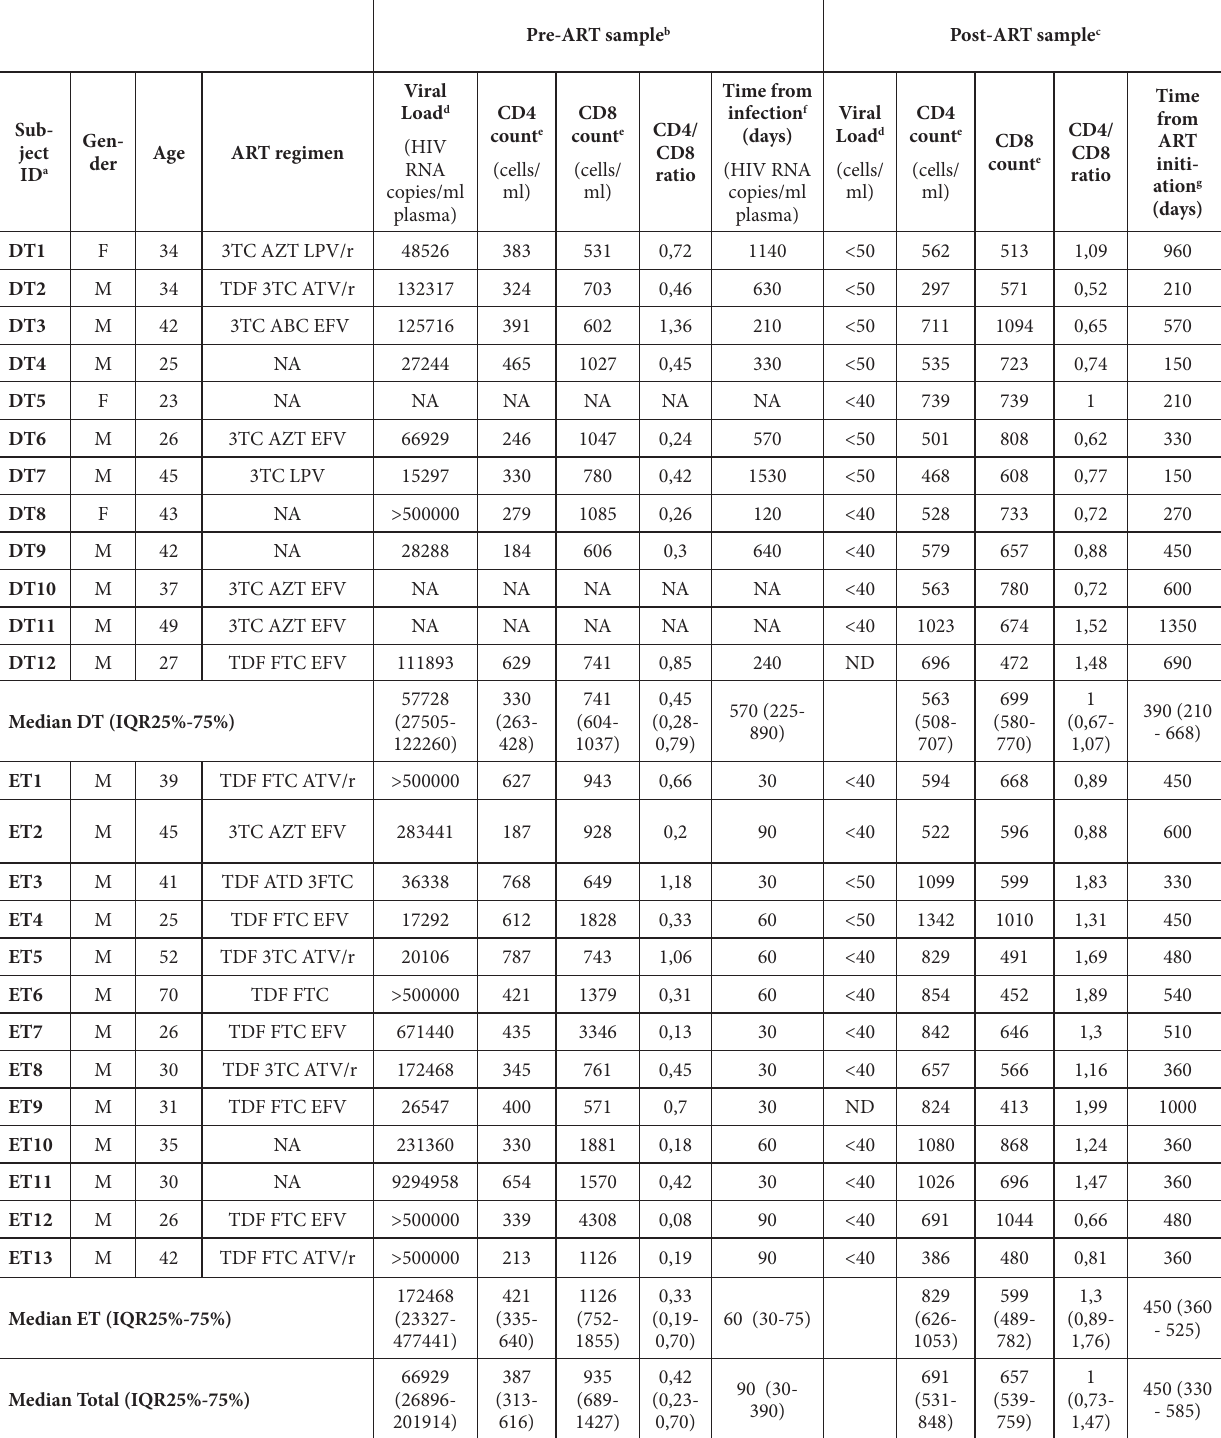
Table 1: Characteristics of enrolled